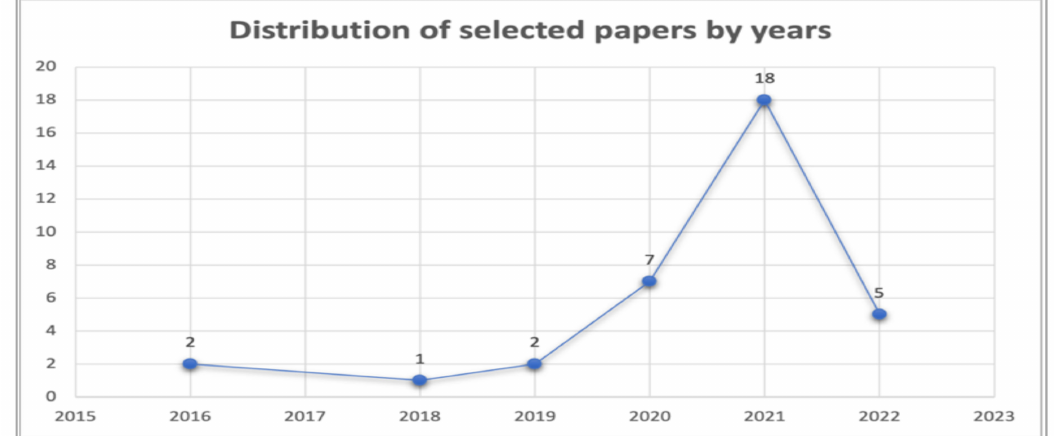
Figure 5. Distribution of the selected papers’ publication